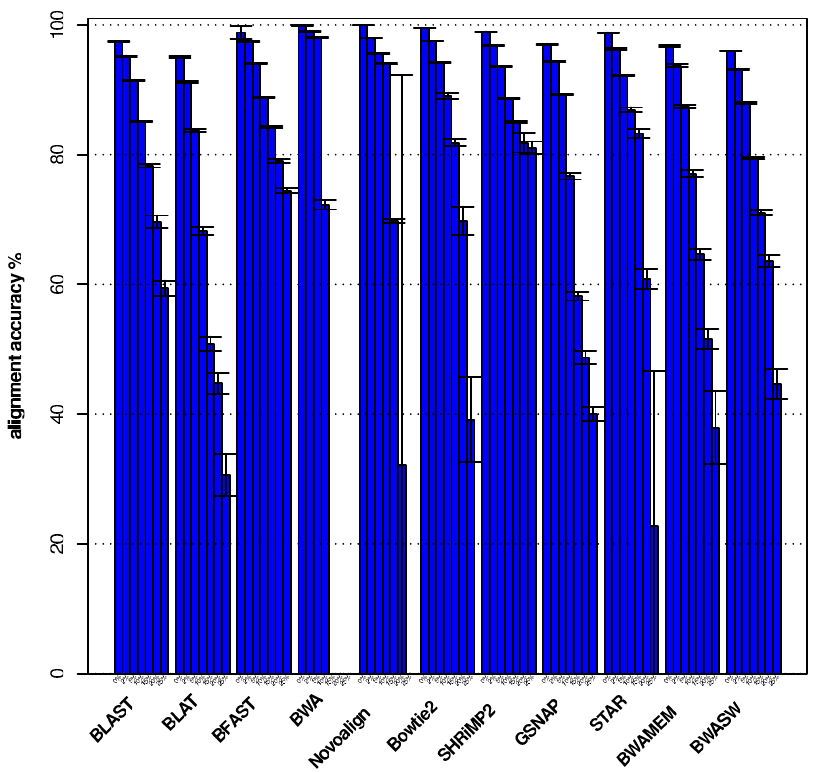
Figure 4. Histogram plot of the average accuracy as a function of the viral mutation rate. Histogram plot of the average accuracy as a function of the mutation rate for each aligner averaged over the four viral genomes (see Table 1).